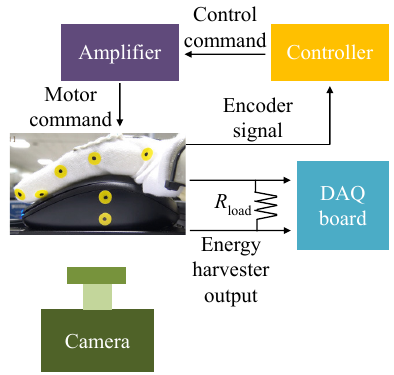
Figure 5. Experimental setup for a robot